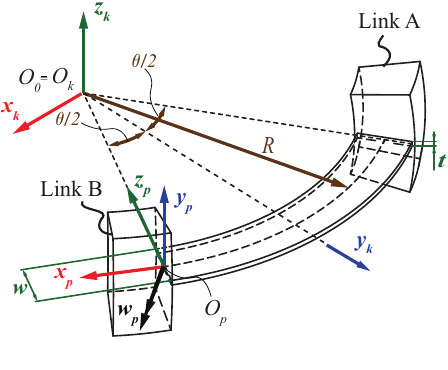
Figure 2. Circular Flexible Beam geometric parameters ( k = 0,1,2).